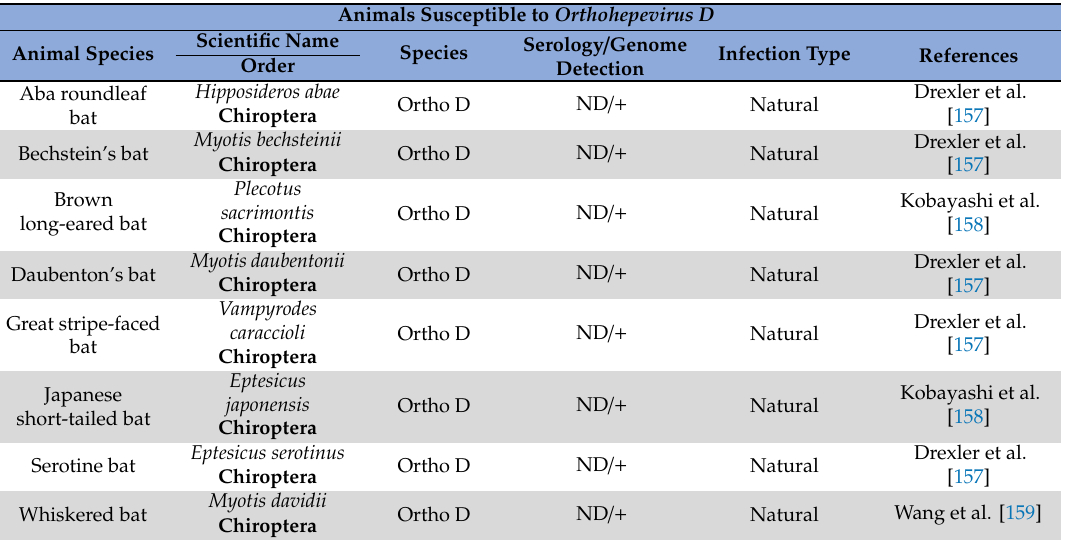
Table 4 Species susceptible to Orthohepevirus D infection. Names in bold represent taxonomic order. Under serology / genome detection “ + ” indicates any positive report for that assay within the literature and “ND” indicates the test was not performed (Not